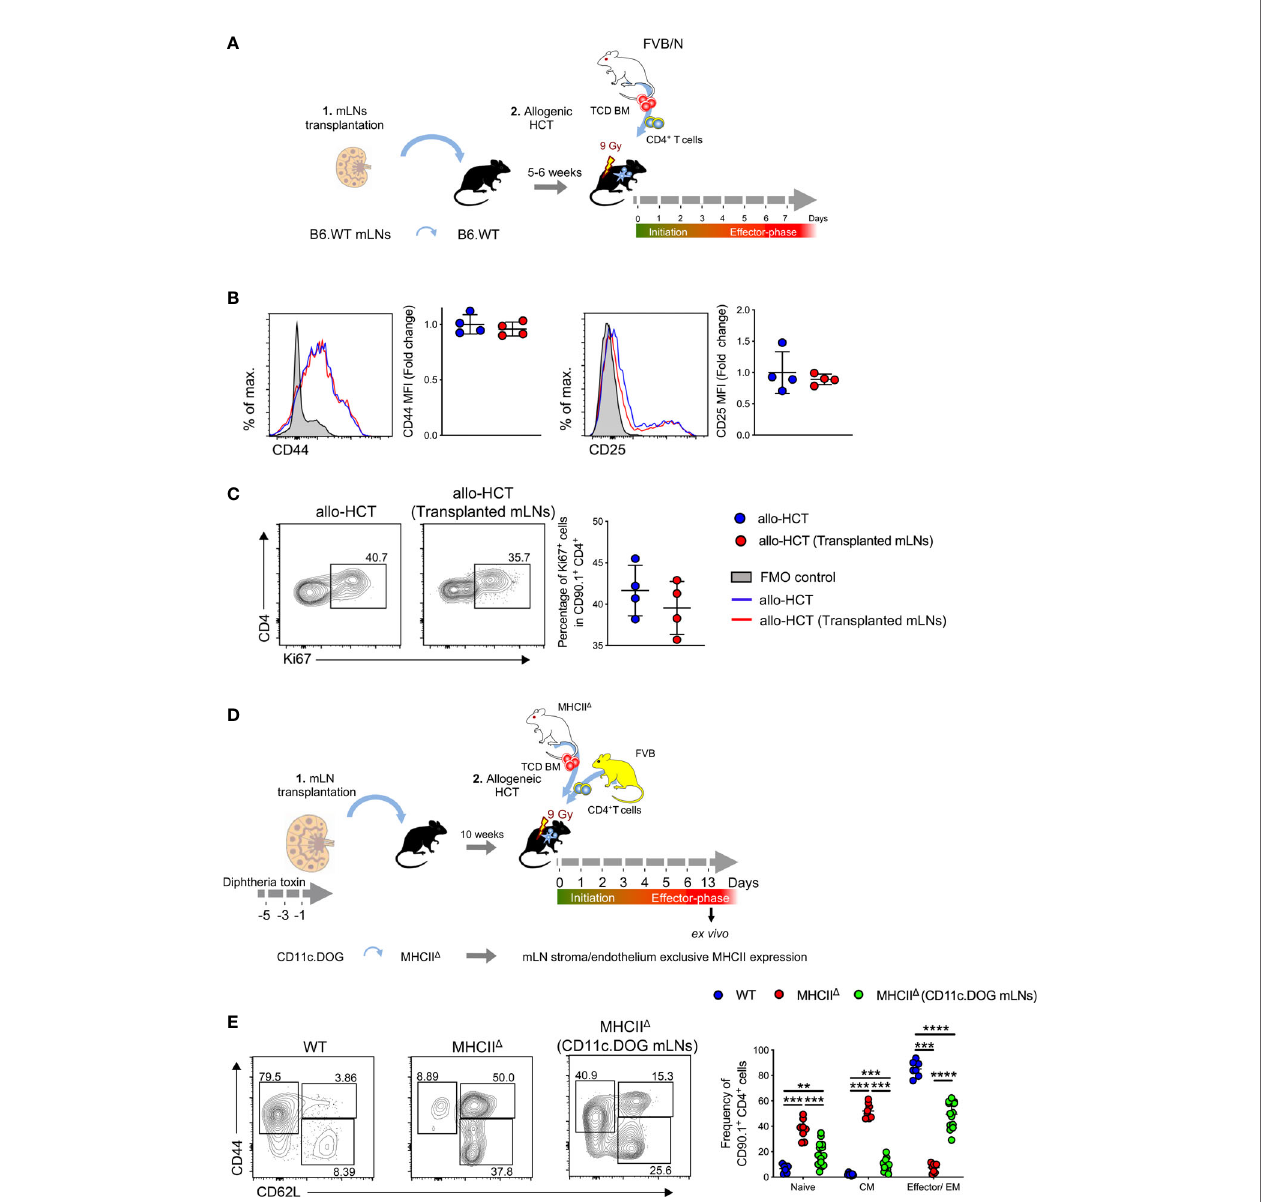
FIGURE 5 | Alloreactive CD4 + T cells are robustly activated in the transplanted mLNs under aGvHD in fl ammatory conditions. (A) Experimental strategy: mLNs from B6.WT mice were transplanted into B6.WT recipient; 5-6 weeks post-surgery; MHC major mismatch aGvHD was induced by lethal irradiation (9 Gy) and allogenically transplanting with 5x10 6 TCD BM cells and 5x10 6 CD4 + T cells from FVB/N mice. (B) Mean fl uorescence intensity (MFI) of CD44 and CD25 on donor T cells d+3 of allo-HCT. (C) Proliferative capacity of donor CD4 + T cells were analyzed by expression of Ki67 d+3 of allo-HCT. (D) Experimental strategy: mLNs of B6.MHCII D mouse were surgically removed and transplanted with donor mLNs from B6.CD11c.DOG mice that had been depleted of CD11c + cells by i.p. administration with diphtheria toxin 20 ng/gram body weight day -5, -3, and -1 day before surgery. 10 weeks post-surgery MHCII D (CD11c.DOG mLNs), untreated B6.WT and MHCII D mice were myeloablatively irradiated with 9 Gy and i.v. transplanted with 5x10 6 T cell-depleted (TCD) BM and 5x10 6 CD4 + T cells from MHCII D and FVB mice respectively. (E) Analysis for T cell subsets - CD44 and CD62L (pre-gated on CD4 + CD90.1 + ) on day +13 of allo-HCT from mLNs. Each data point represents one mouse, data pooled from two experiments; unpaired non-parametric Mann-Whitney test, (Mean± SD); ** p < 0.01, *** p < 0.001 and **** p <